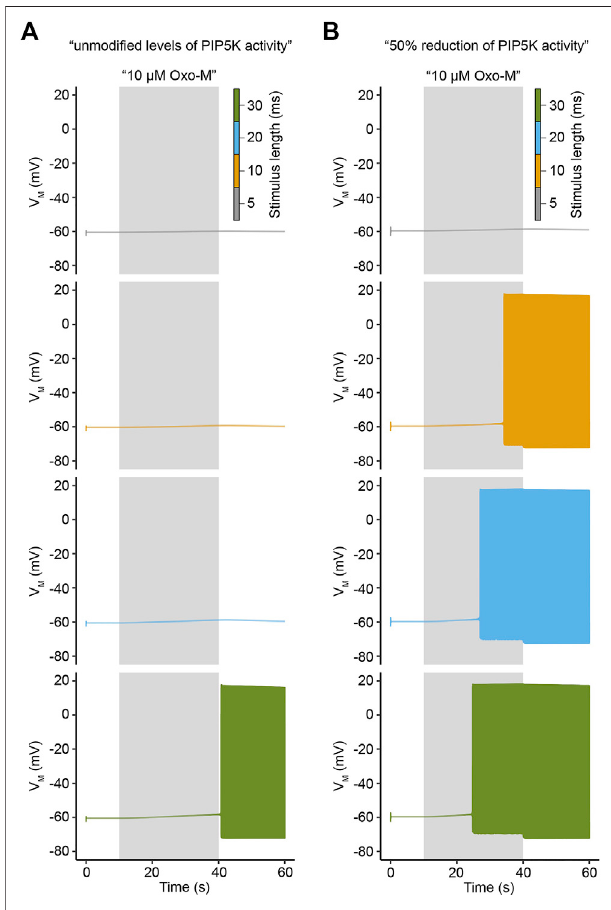
FIGURE 7 | In fl uence of stimulus duration on electrical activity under varying conditions of PIP5K activity. (A) . Simulated membrane potentials in response to a 30 s application of 10 μ M Oxo-M for indicated stimulus lengths at a stimulation frequency of 10 Hz under conditions of unmodi fi ed PIP5K activity. (B) . Same as in A, but for 50% reduction of PIP5K